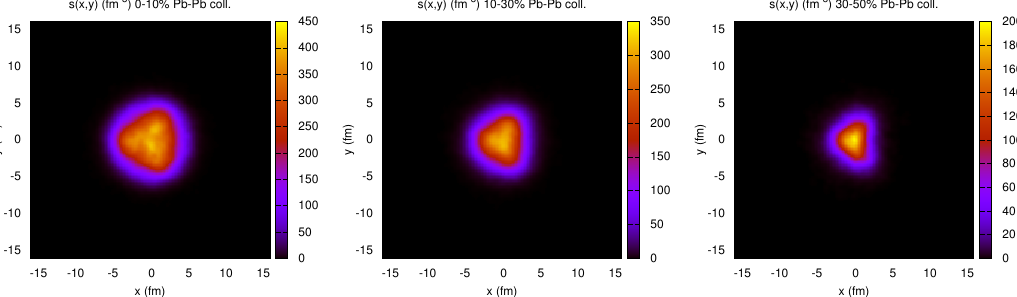
Figure 2 . Glauber-MC initial conditions for the entropy density at (cid:28) 0 =0 : 5 fm/c for the study of p the triangular (cid:13)ow in Pb-Pb collisions at s NN = 5 : 02 TeV in di(cid:11)erent centrality classes. All the events have been rotated to have the event-plane angle 3 aligned along the x -axis. nucleon